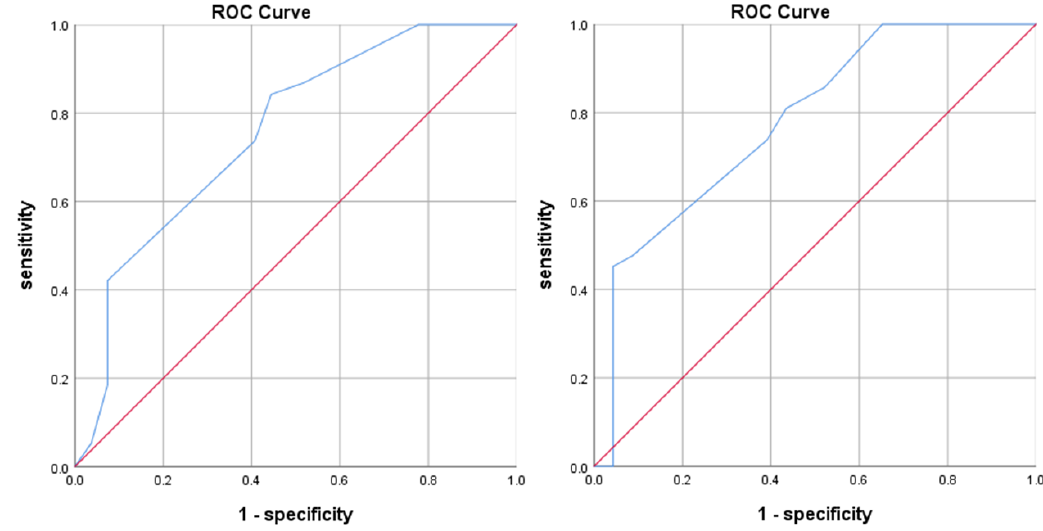
Figure 2. ROC curves for the internal validation ( left ) and validation cohorts ( right ).